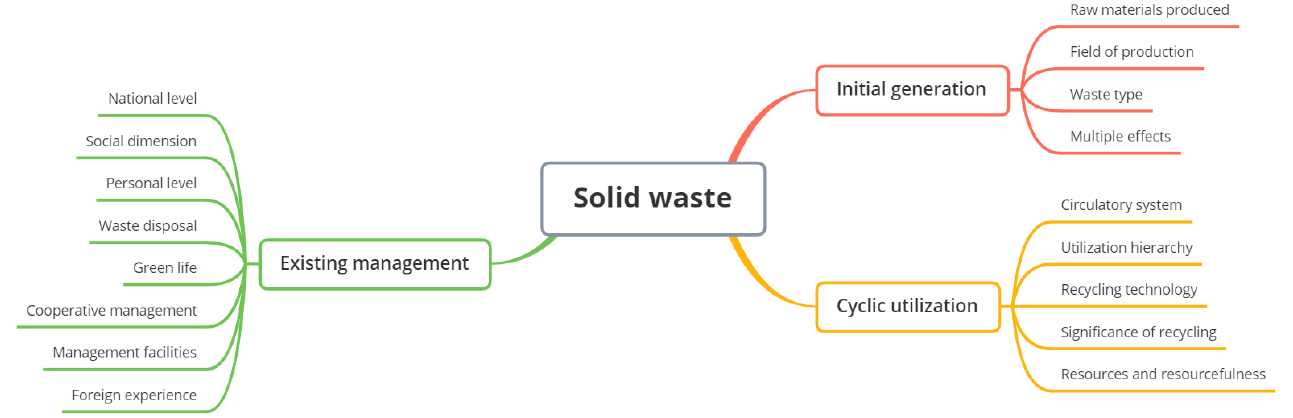
Figure 3. Mind map of literature research frameworks.